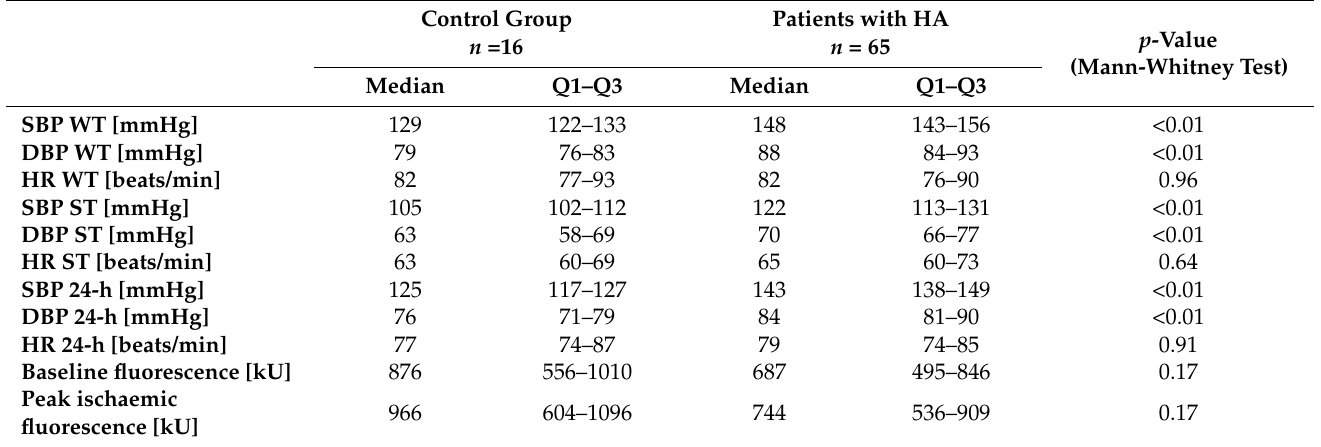
Table 1. The mean blood pressure and heart rate values in ABPM in the patients with HA